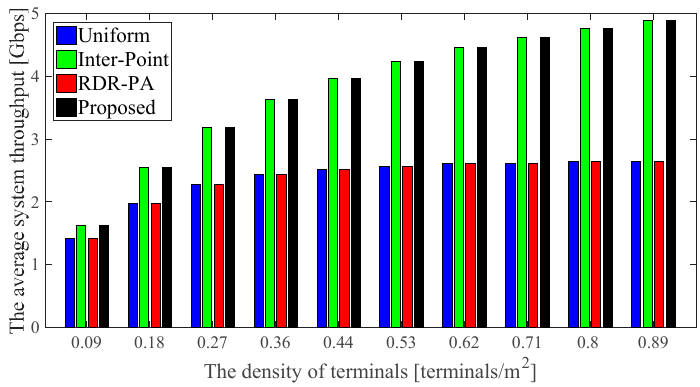
Figure 2. The average system throughput versus the density of terminals.